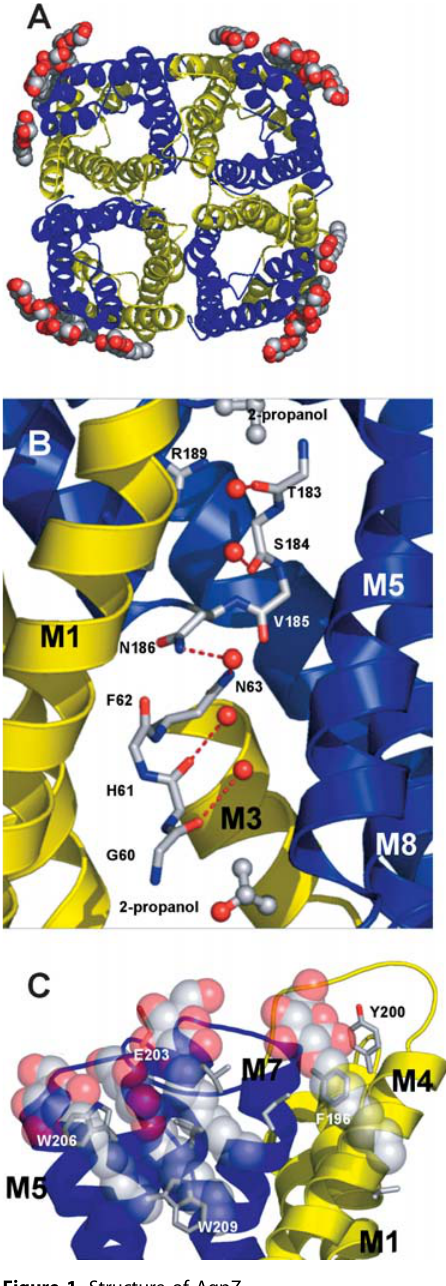
Figure 1. Structure of AqpZ Three-dimensional fold of AqpZ with the quasi-2-fold related segments in yellow (residues 1–117) and blue (residues 188–231). (A) Cartoon representation of the AqpZ tetramer with OG detergent molecules represented as spheres; view is from the periplasmic side. Atoms are colored according to atom type (red, oxygen; gray, carbon; blue, nitrogen; yellow, sulfur). (B) Cartoon representation of the AqpZ monomer, with M2 and M6 removed for ease of viewing. Single-file water is shown hydrogen- bonding to carbonyls of main chain. Central water is shown accepting a hydrogen bond from the NH2 group of Asn63 and Asn186. Sidechains of the selectivity filter are also shown. Isopropanol molecules located in density are shown as sticks, just outside the channel. (C) A view from the membrane plane of the OG micelle interactions with the periplasmic segment of AqpZ. OG molecules pack against the aromatic sidechains, while making hydrogen bonds with the main chain carbonyls, E203, and each other. All figures were made with PyMOL (DeLano 2003). DOI: